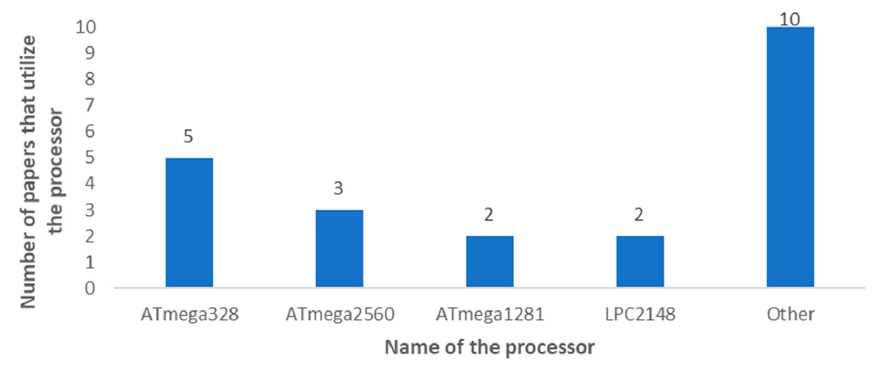
Figure 24. Most utilized processors to implement IoT nodes for irrigation systems.